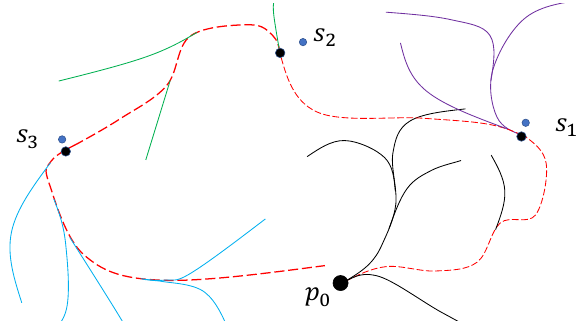
Figure 5. A illustrative feasible inspection tour. The random trees are in different colors, and the red dash curve is a feasible tour. The feasible tour is obtained by repeatedly backtracking the parent of the vertex from the one falling into the neighbourhood of p 0 in the last random